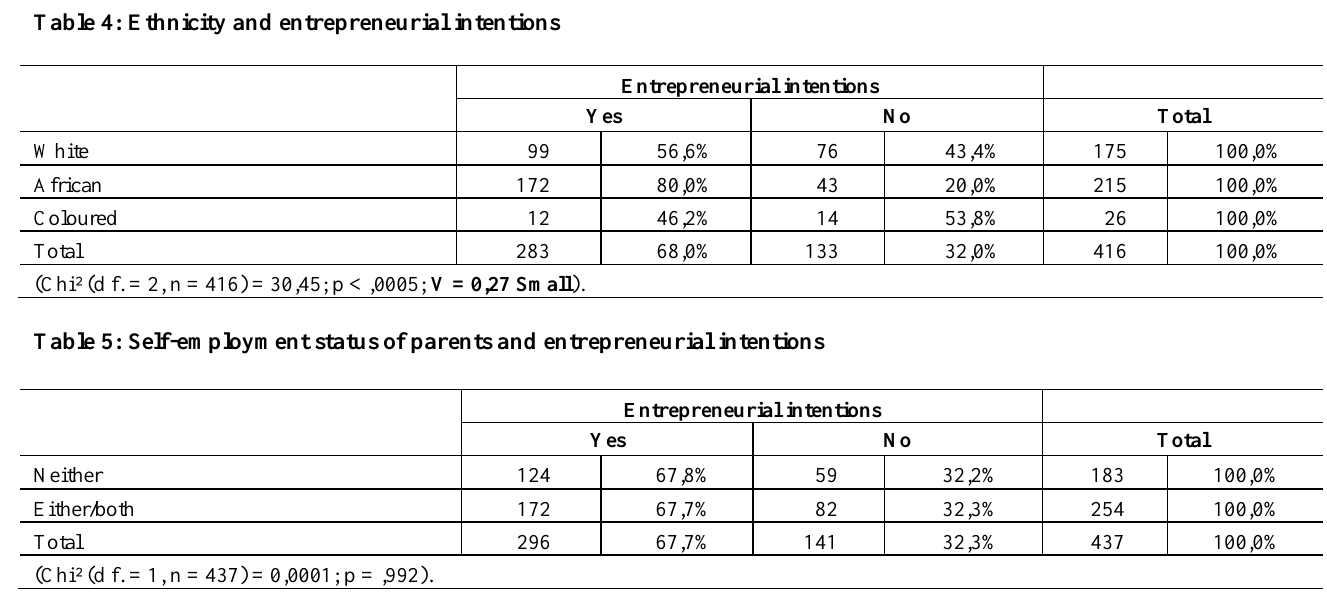
Table 4: Ethnicity and entrepreneurial intentions